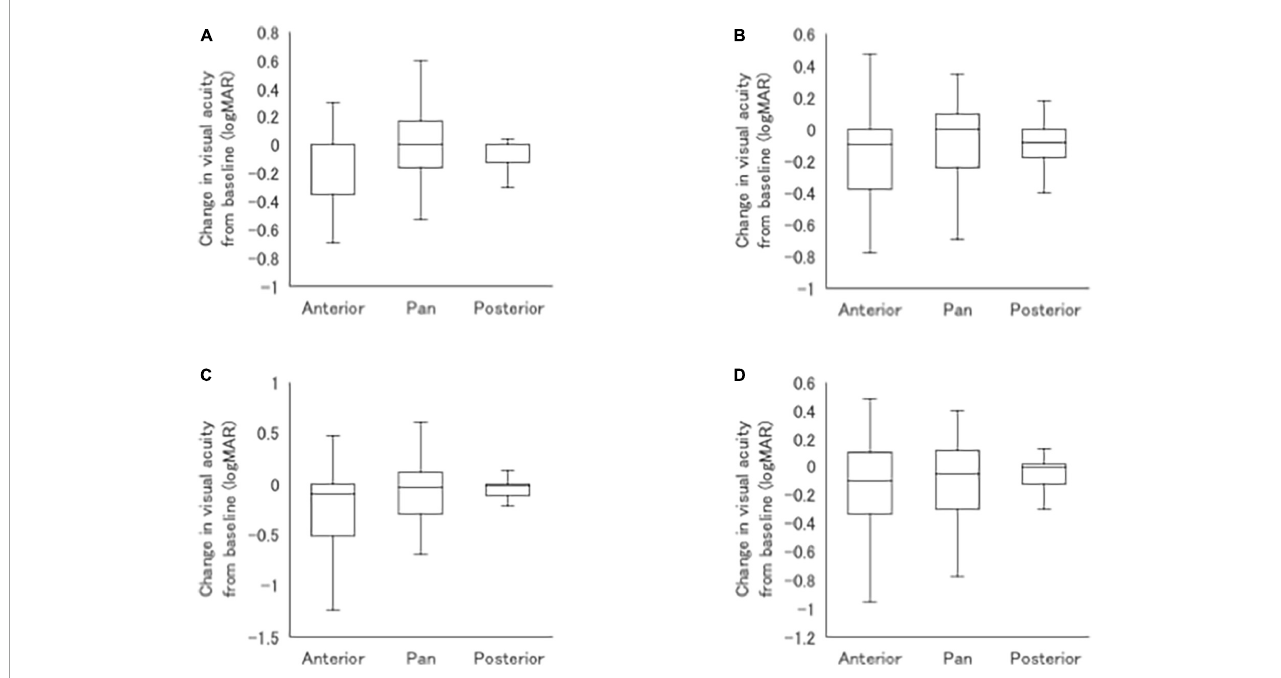
FIGURE5 Comparisons of mean changes in logMAR VA from baseline between patients with recurrent anterior uveitis, posterior uveitis, and panuveitis at 1 (A) , 3 (B) , 5 (C) , and 10 (D) years after initiation of